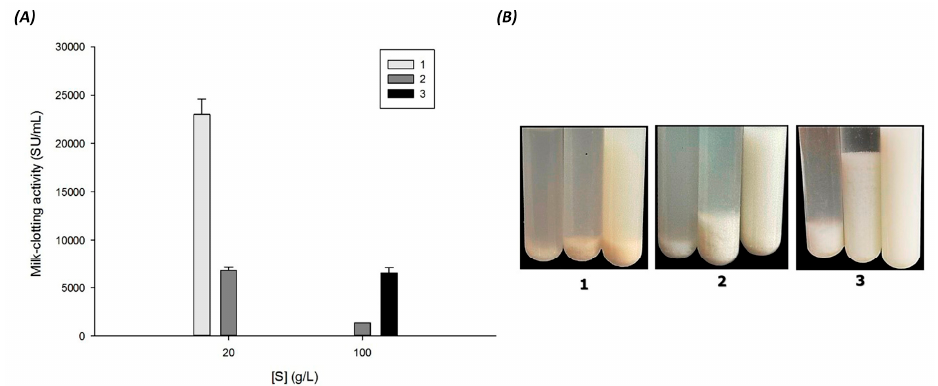
Figure 6. Milk-clotting activity from seed crude extract of M. oleifera on different types of commercial soy milk. ( A ): Left plot was drawn using the data obtained from the milk-clotting activity assay with different types of soy milk. ( B ): Right image shows the curd formation in test tubes. Substrate 1: AdeS; Substrate 2: Soyapac; Substrate 3: Soyalac. Asterisks represent statistical significance (three separate experiments) based on variance (one-way ANOVA), followed by HSD ( p < 0.05 vs. Substrate 2: Soyapac).